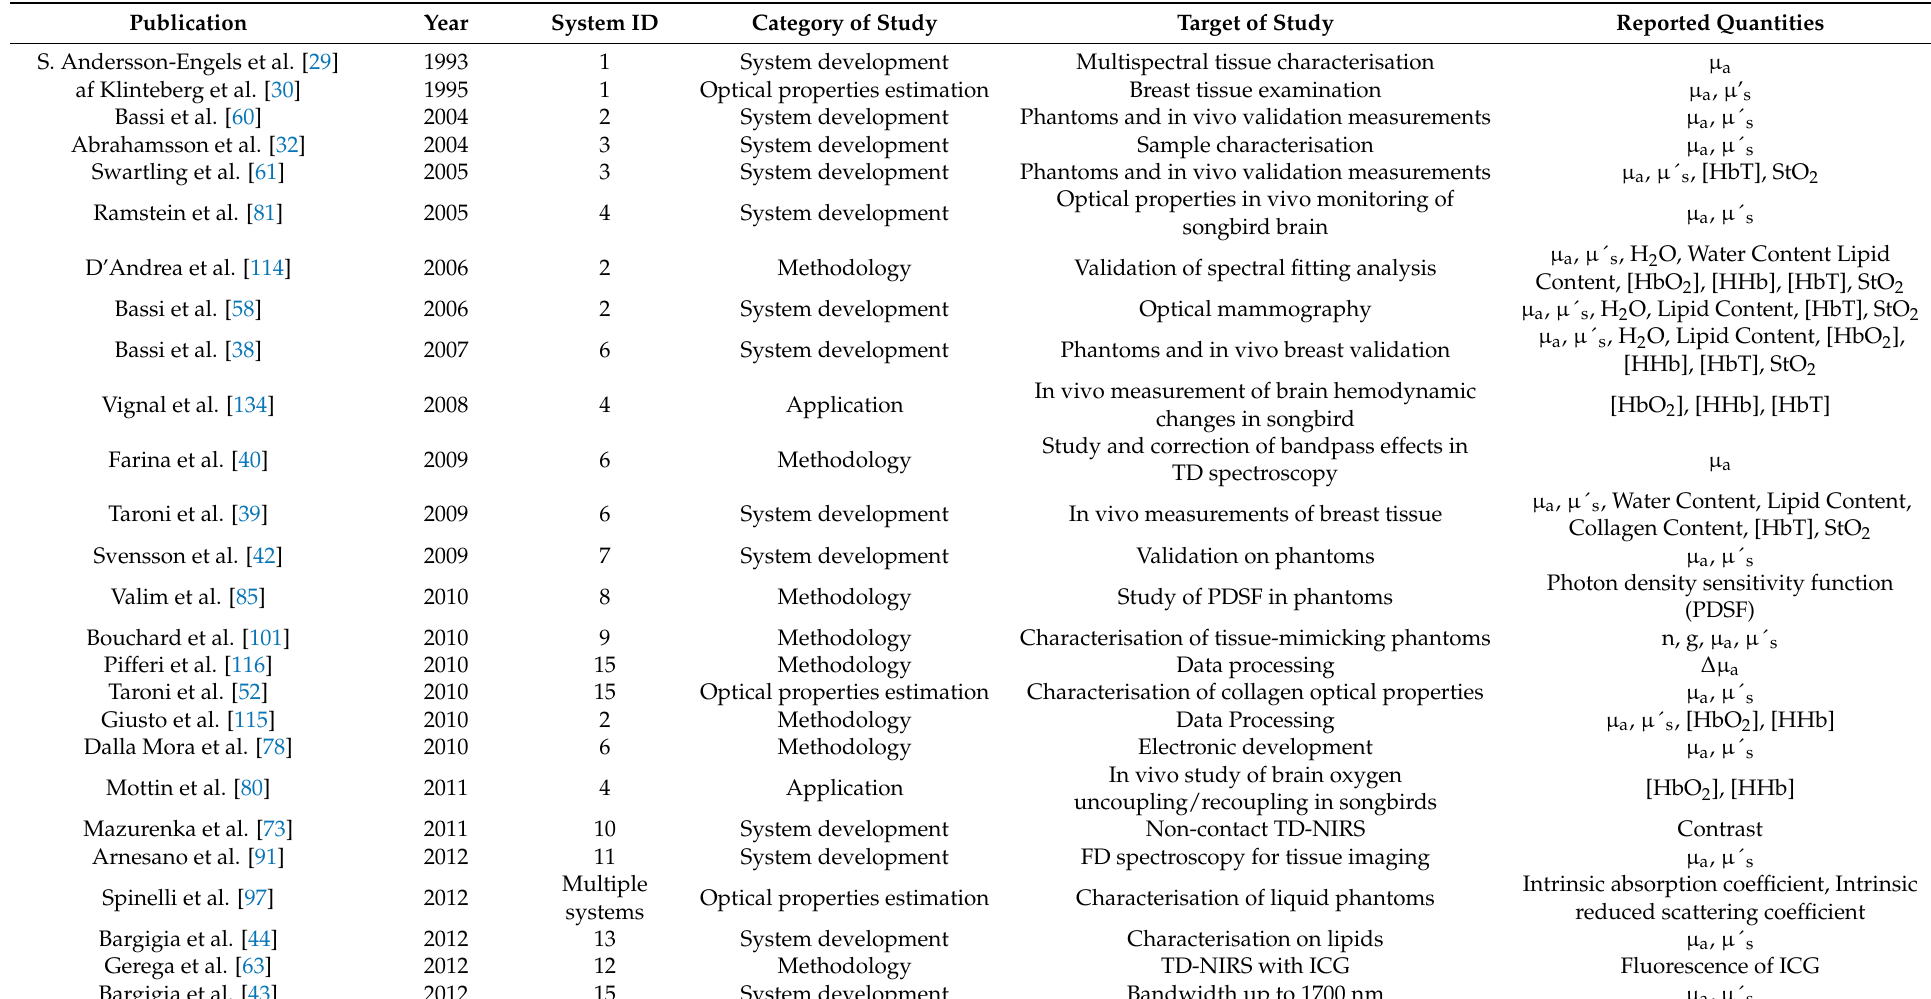
Table 2. Table of the literature review of the use of SC lasers in biomedical diffuse optics. The system used in each study are described more in detail in Table 1 and referred to as “system ID”. µ a : absorption coefficient, µ ’ s : reduced scattering